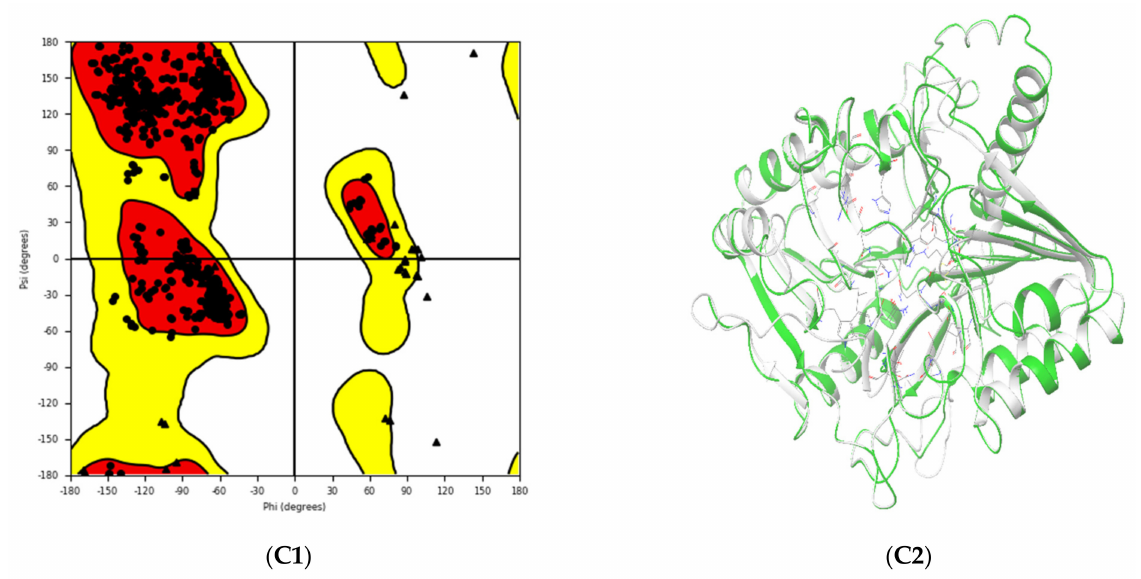
Figure 2. Ramachandran plots of the generated protein structures (Left). The red colors in the Ramachandran plots indicate the most allowed regions; the generously allowed regions are shown in yellow, and the disallowed regions are shown in white. The triangles indicate glycine, the squares indicate proline, and all other residues are plotted as circles. On the right of the figure, the superimposition of the generated structures in 3D (green) with those of reference proteins that were used as a template for the model generation is shown; their PDB IDs are: 6RFL_C (violet), 4E9O_A (yellow), and 7E0M_A (white). ( A ). DNA-Dependent RNA Polymerase subunit (A6R), ( B ). Carbonic anhydrase (GAG-binding IMV membrane protein) (D8L), ( C ). Palmitoylated extracellular enveloped virus (EEV) membrane glycoprotein